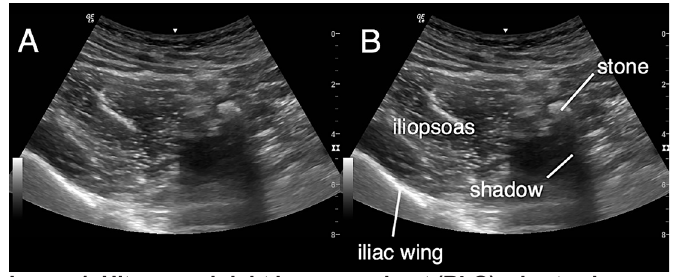
Image 1. Ultrasound right lower quadrant (RLQ), short axis, curvilinear probe. The landmarks of a RLQ ultrasound can be noted in short axis using the curvilinear probe with the iliac wing and iliopsoas muscle in view. Medial to the iliopsoas a hyperechoic focus representing a stone with acoustic shadowing is noted.